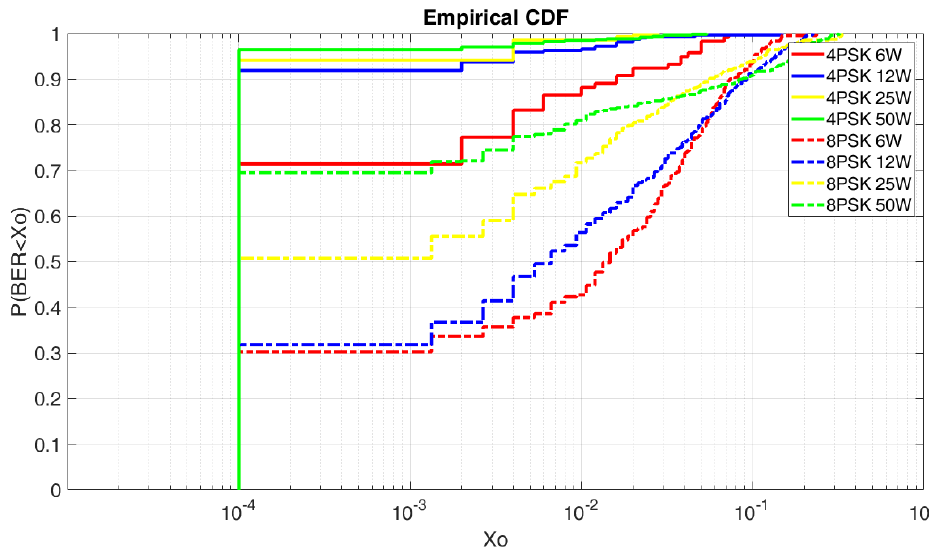
Figure 11. Selection combining (SC) BER CDF according to power transmission.